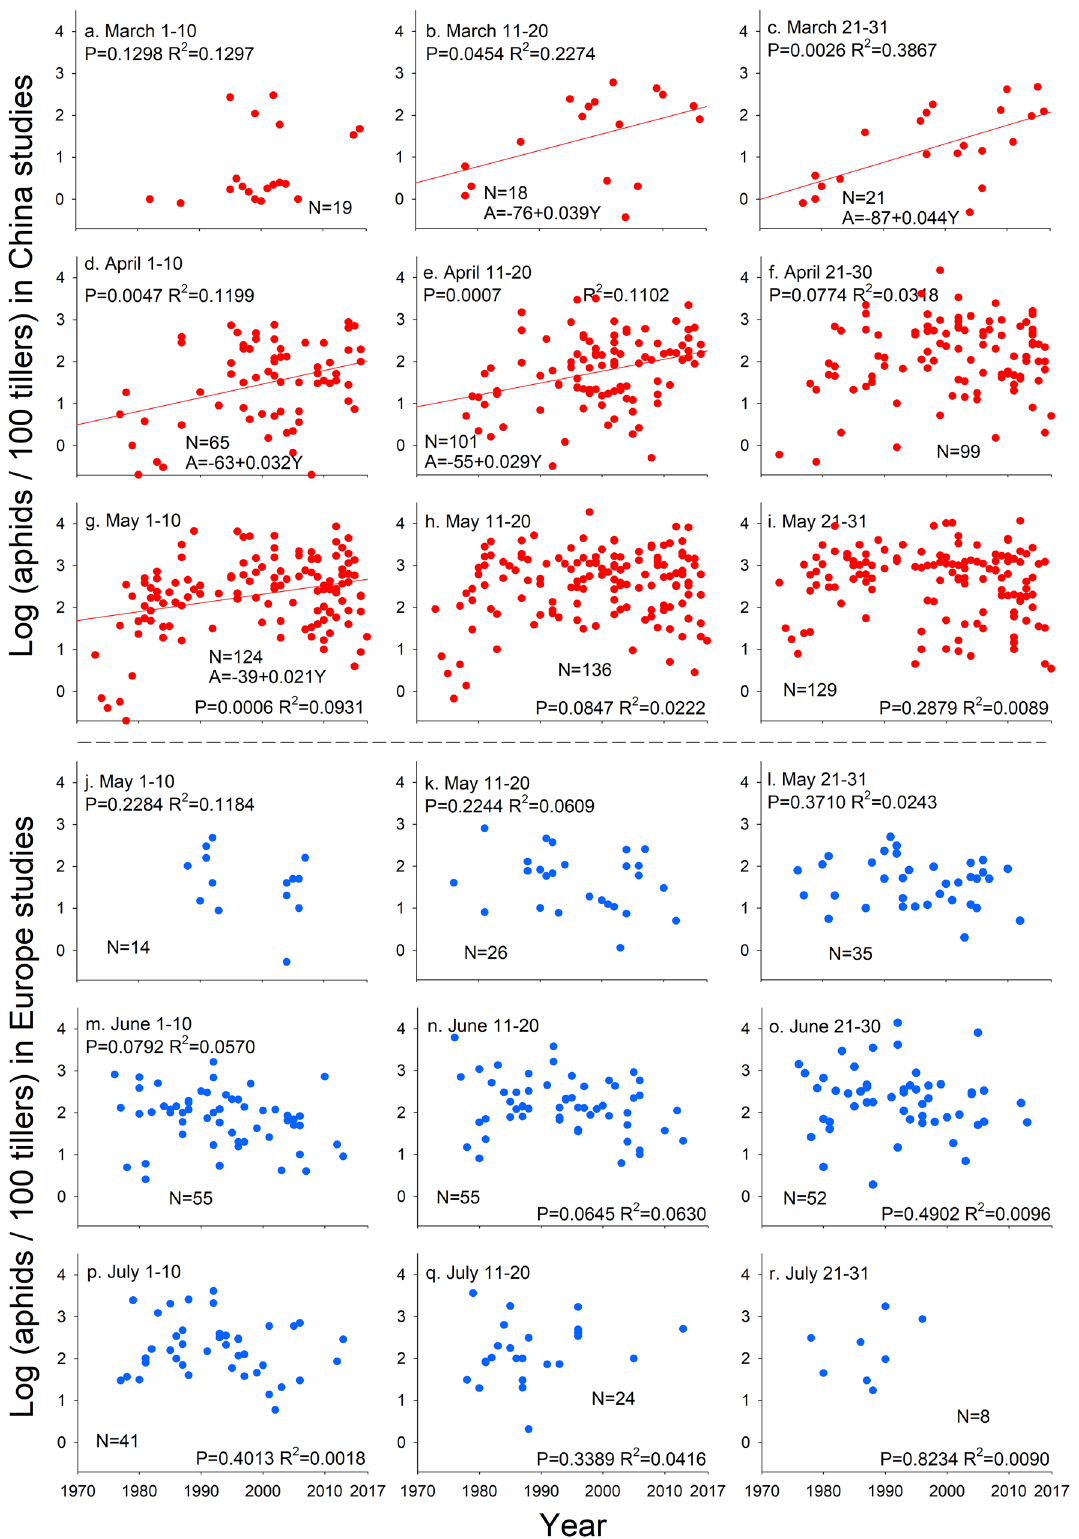
Fig. 1 Historical wheat aphid loads in China and Europe by season. Wheat aphid (log transformed) loads in different times of the year in China ( a – i ) and Europe ( j – r ) during 1970 – 2017. P and R 2 values are from regressions. Lines indicate signi fi cant linear relationships between aphid loads and time. Including a random term for paper or for province (China) or country (Europe) makes the relationship in b not signi fi cant but the other signi fi cant relationships are